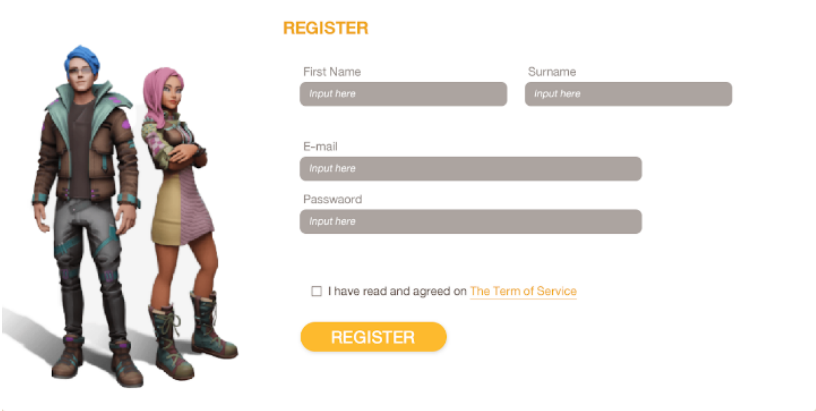
Figure 2. The platform uses Playfab as the back-end service to keep all of the user’s personal information, such as avatar configurations, usage statistics, and scores.